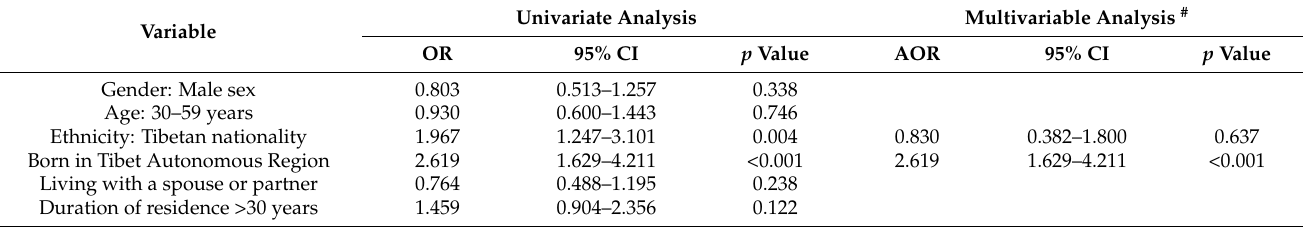
Table 6. Influencing factors for psychological and social fitness: Logistic regression